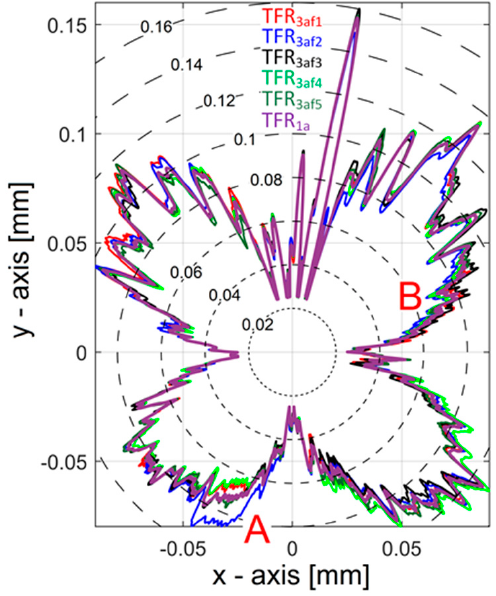
Figure 20. The evolution of TFR 3af trajectory for five successive real trajectories (TFR 3af1 ÷ TFR 3af5 ) and the evolution of TFR 1a .